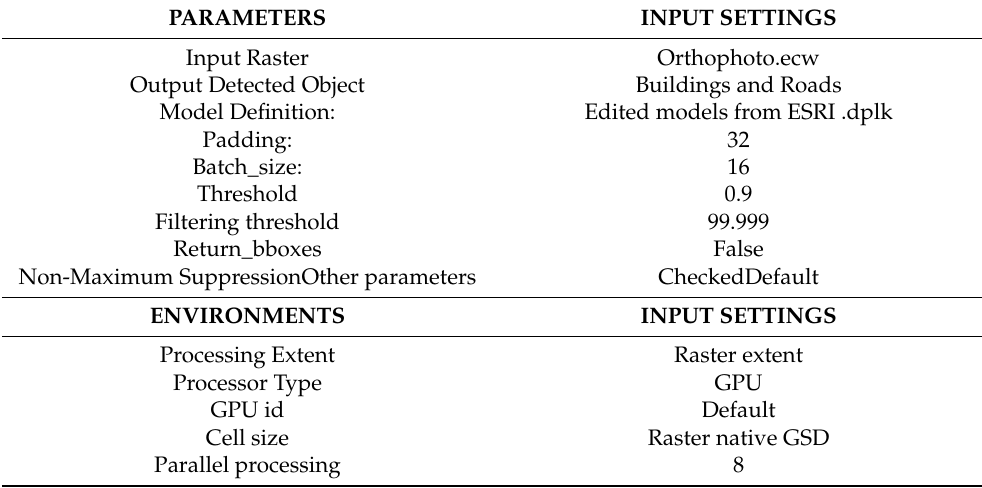
Table 7. Deep learning CNN settings in ArcGIS Pro